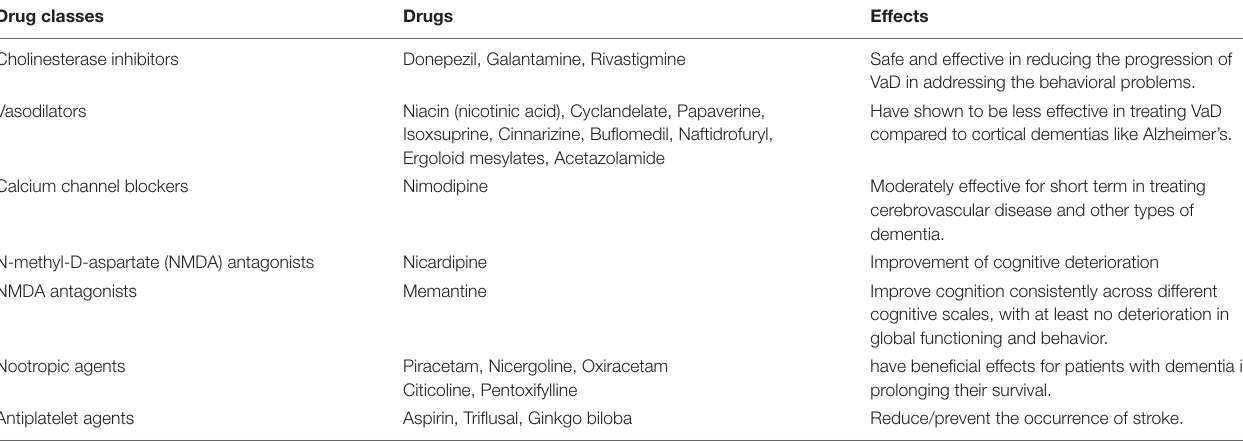
TABLE 5 | Pharmacological treatment for VaD and their